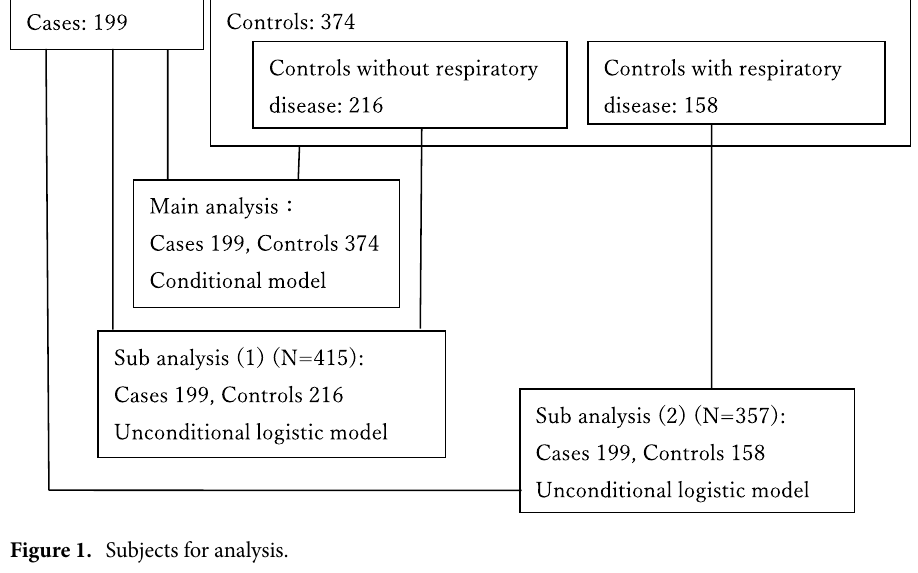
Figure 1. Subjects for analysis.